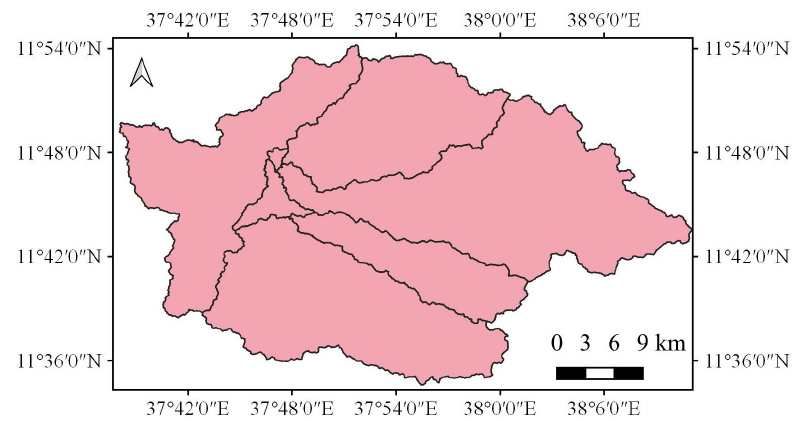
Figure 4. Gumera watershed in the Abbay River Basin.